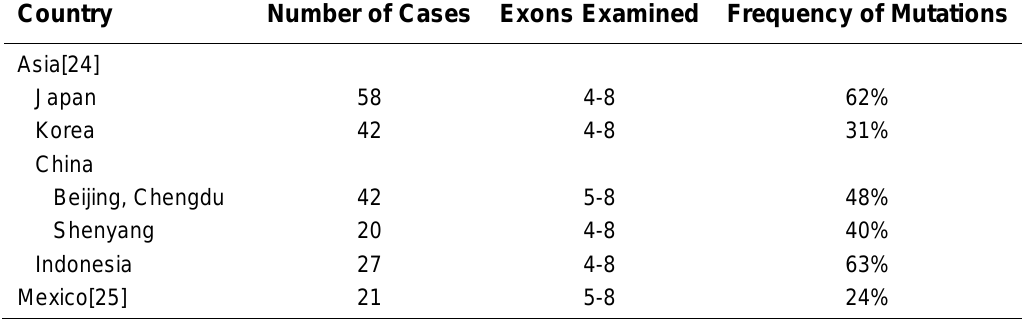
p53 Mutations in Nasal NK/T-Cell Lymphoma